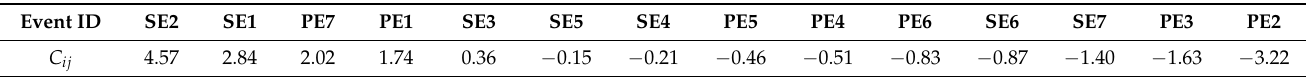
Table 11. Cross-impact ranking of source and process events on resultant event